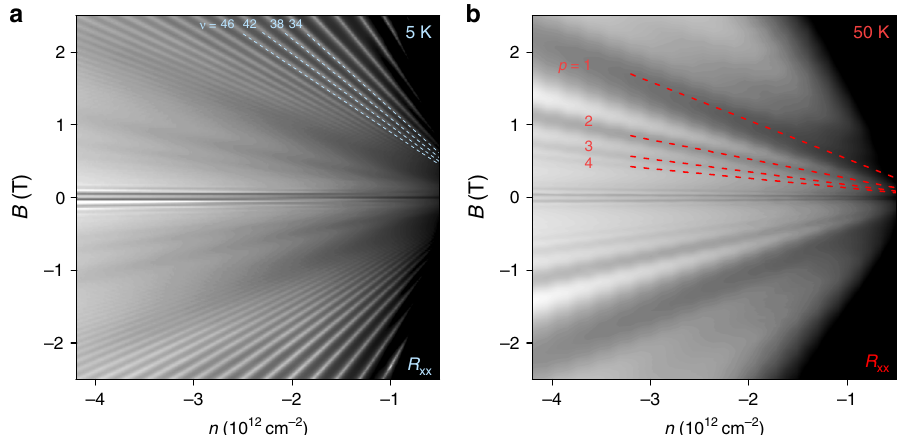
Fig. 3 Density dependence of magnetophonon oscillations. a Longitudinal resistance R xx (grey scale map) as a function of n and B measured at 5 K ( W = 15 μ m). Logarithmic grey scale: white: 1 Ω to black: 15 Ω . The blue dashed lines trace Landau gaps corresponding to high fi lling factors ν = nh / Be . b Same as a measured at 50 K. Logarithmic grey scale: white: 5.5 Ω to black: 18 Ω . The red dashed lines plot Eq. (1) for p = 1 to 4 which corresponds to carriers scattering with transitions across 1 to 4 Landau level spacings. Features appearing for B < 0.2 T are the semiclassical geometrical oscillations 4 not relevant in this work (see Supplementary Note 2 for